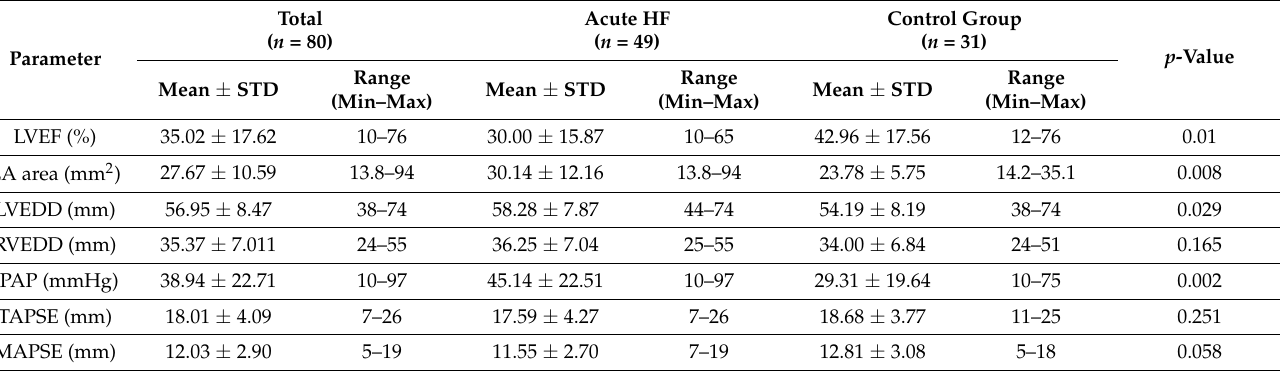
Table 5. Echocardiography parameters in acute HF and control